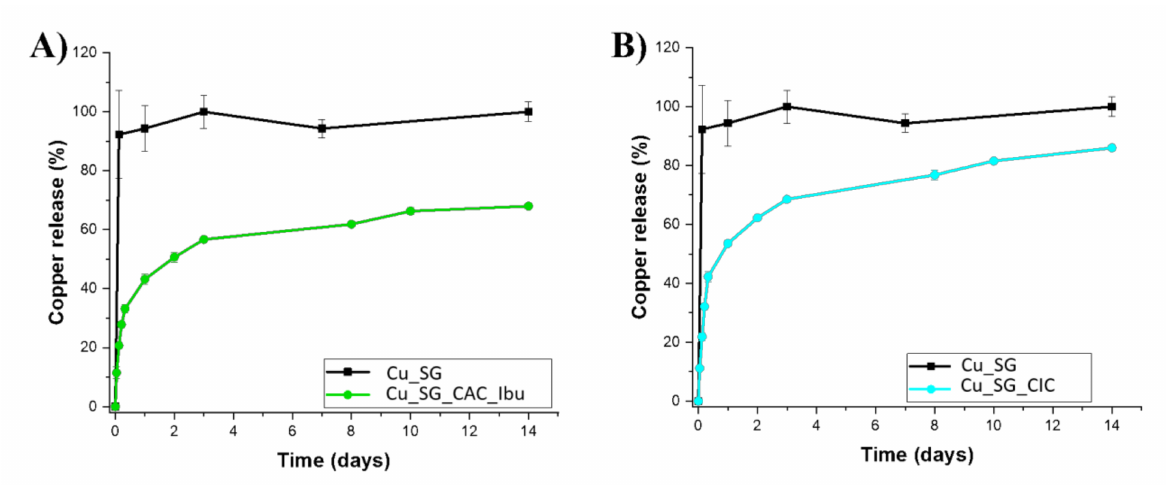
Figure 8. Copper release profile of ( A ) Cu_SG_CAC_Ibu and ( B ) Cu_SG_CIC in Tris-HCl compared to the bare sample